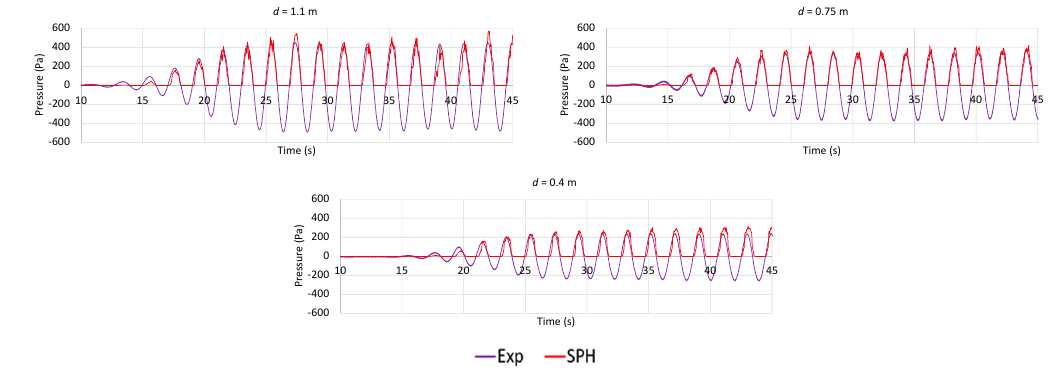
Figure 18. Dynamic wave pressure for A = 50.5 mm and T = 1.95 s.